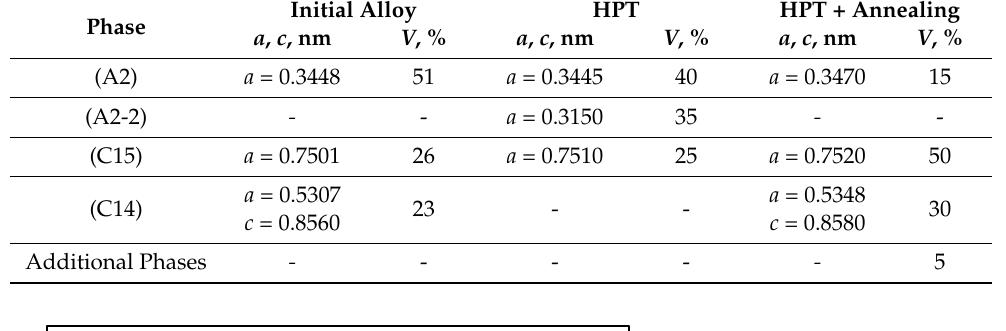
Table 4. Phases, lattice parameters, and the percentage of the phases V in the TiZrHfMoCrCo alloy after HPT and HPT plus annealing at 1000 °C.